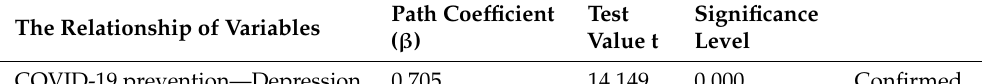
Figure 10. The fourth sub-hypothesis model includes factor load coefficients.